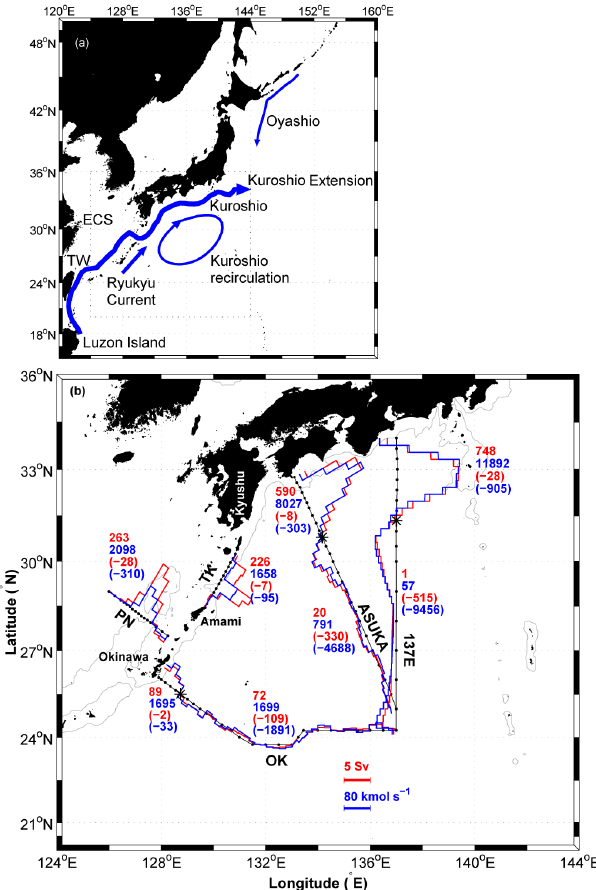
Fig. 1. (a) Study area and schematic image of the Kuroshio path, Kuroshio recirculation, and the Ryukyu Current. ECS: East China Sea; TW: Taiwan. (b) Position of the hydrographic stations (black dots), volume transport (red line, 1Sv = 10 6 m 3 s − 1 ) and nitrate transport (blue line, kmols − 1 ) integrated from the sea surface to the deepest layer with 25km width. The positive direction for two trans- ports is defined as the same direction as the Kuroshio or Ryukyu Current. The thin straight lines connecting the black dots serve as a reference point for the transports. For the calculation method of these variables, see Eqs. (4)–(6) and their description in Sect. 2. “PN”, “TK”, “OK”, “ASUKA”, and “137E” indicate the names of the sections. The Tokara Strait is located in section TK. The thin curved line denotes the 200m isobath. The black asterisks separate section OK into two parts: section OK-W to the west and section OK-E to the east; section ASUKA into two parts: section ASUKA- N to the north and section ASUKA-S to the south; and section 137E into two parts: section 137E-N to the north and section 137E-S to the south. There are four numbers for each section: the two red num- bers indicate positive and negative volume transports through the section within a unit of 0.1Sv, and the two blue numbers indicate positive and negative nitrate transports through the section within a unit of 0.1kmols − 1